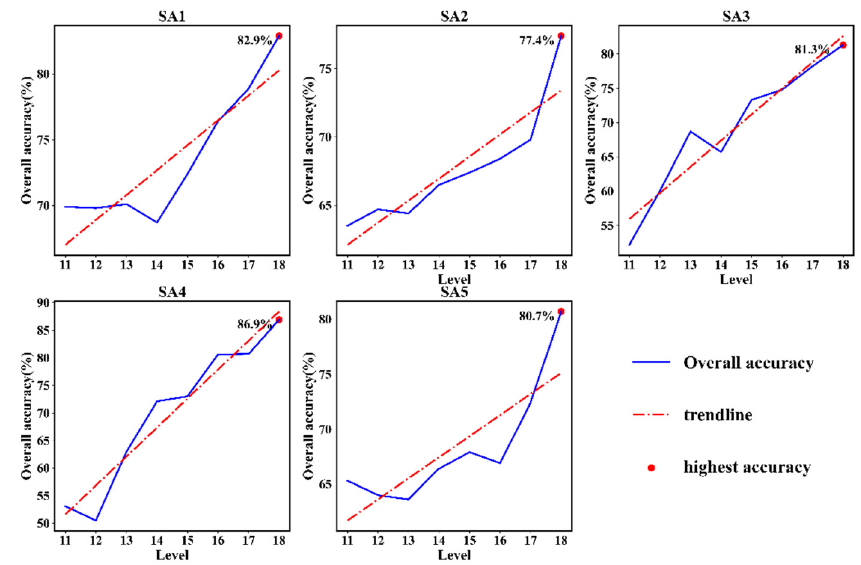
Figure 7. The relationship between the spatial resolution of input imagery and the OA for the five